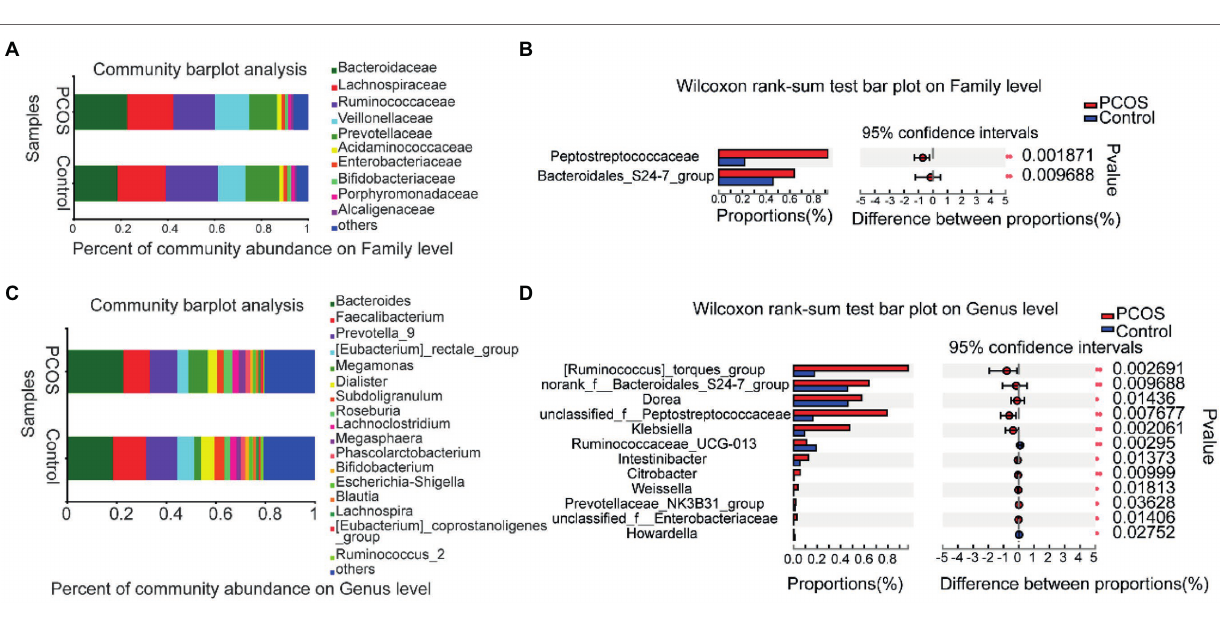
FIGURE 4 | (A,B) At family level, the composition and differences of gut microbiota between PCOS and healthy controls were observed. (C,D) Composition and differences of gut microbiota at genus level between PCOS and healthy controls. The difference of intestinal flora between the two groups was compared by STAMP analysis. PCOS: polycystic ovary syndrome ( N = 31); Control: healthy controls ( N = 27). * p ≤ 0.05; ** p ≤ 0.01; and *** p ≤